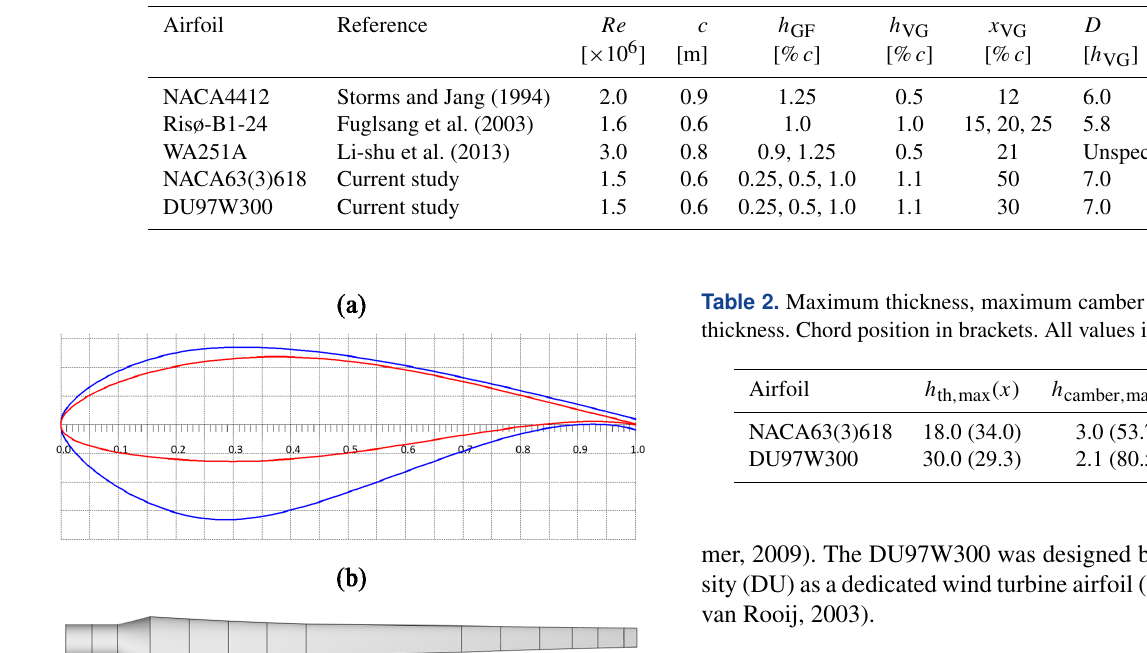
Table 1. Literature references. GF and VG design parameters.